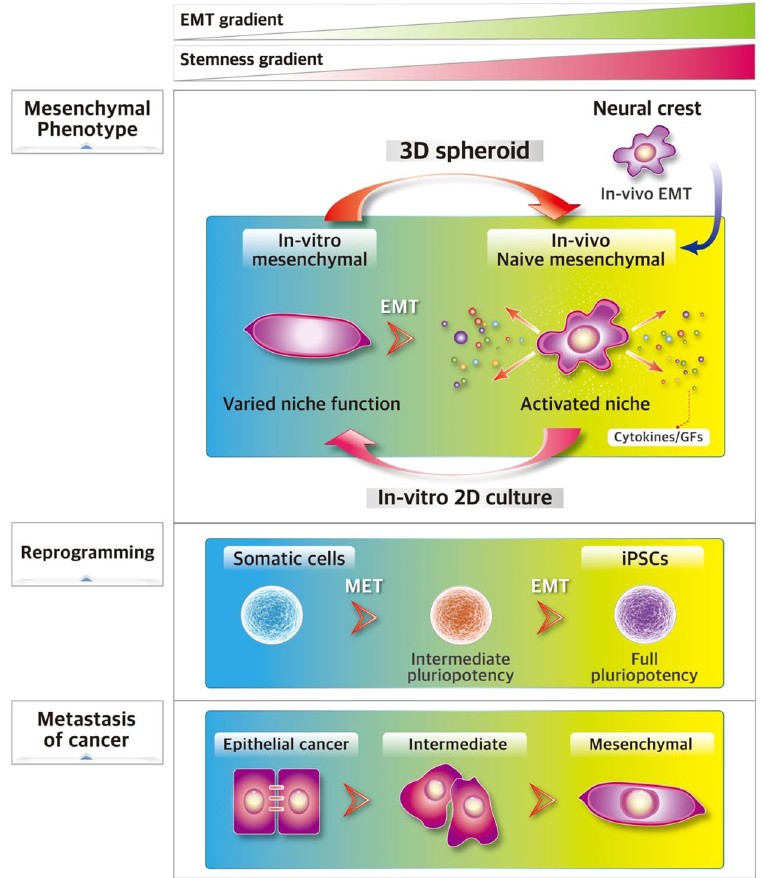
Figure 7. A hypothetical model for the EMT gradient as a functional parameter in cell transitions. MSCs were derived from the neural crest via the EMT, contributing to the in vivo mesenchymal niche. During in vitro 2D adherent culture, MSCs undergo phenotypic and gene expression changes, resulting in discrepancies from the in vivo naïve mesenchymal state and variations in biological niche functions. 3D spheroid culture of MSCs drives the MSCs to a more naïve mesenchymal state, creating molecular heterogeneity in the EMT gradient while preserving the phenotypically redundant mesenchymal phenotype. Models for heterogeneity in the EMT or stemness gradient are also found during cell reprogramming to the pluripotent state; at first, the EMT is downregulated, but is then reactivated during the transition from the intermediate stage to the fully pluripotent stage. Similarly, cancer cells exhibit multiple stages of the EMT/stem cell-like properties, where the hybrid/ intermediate stage of the EMT exhibits both epithelial and mesenchymal properties during metastasis. Thus, the heterogeneity in the molecular EMT gradient can be a functional parameter for a broader spectrum of cell